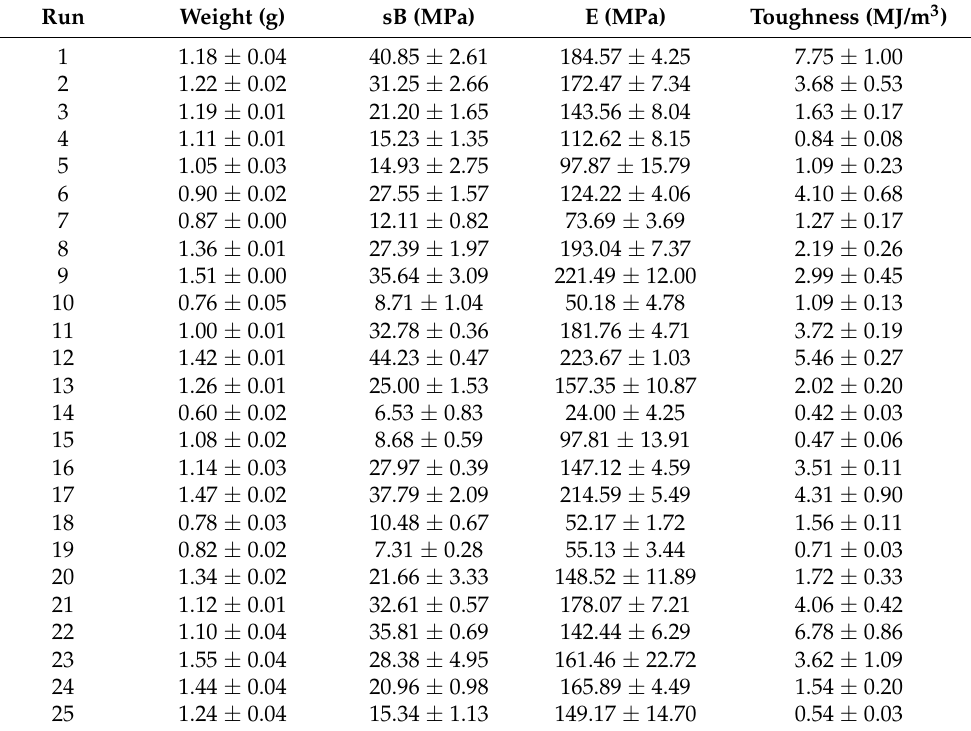
Table 2. Average and standard deviation values of measured responses for weight, tensile strength (sB), tensile modulus of elasticity (E), and tensile toughness.